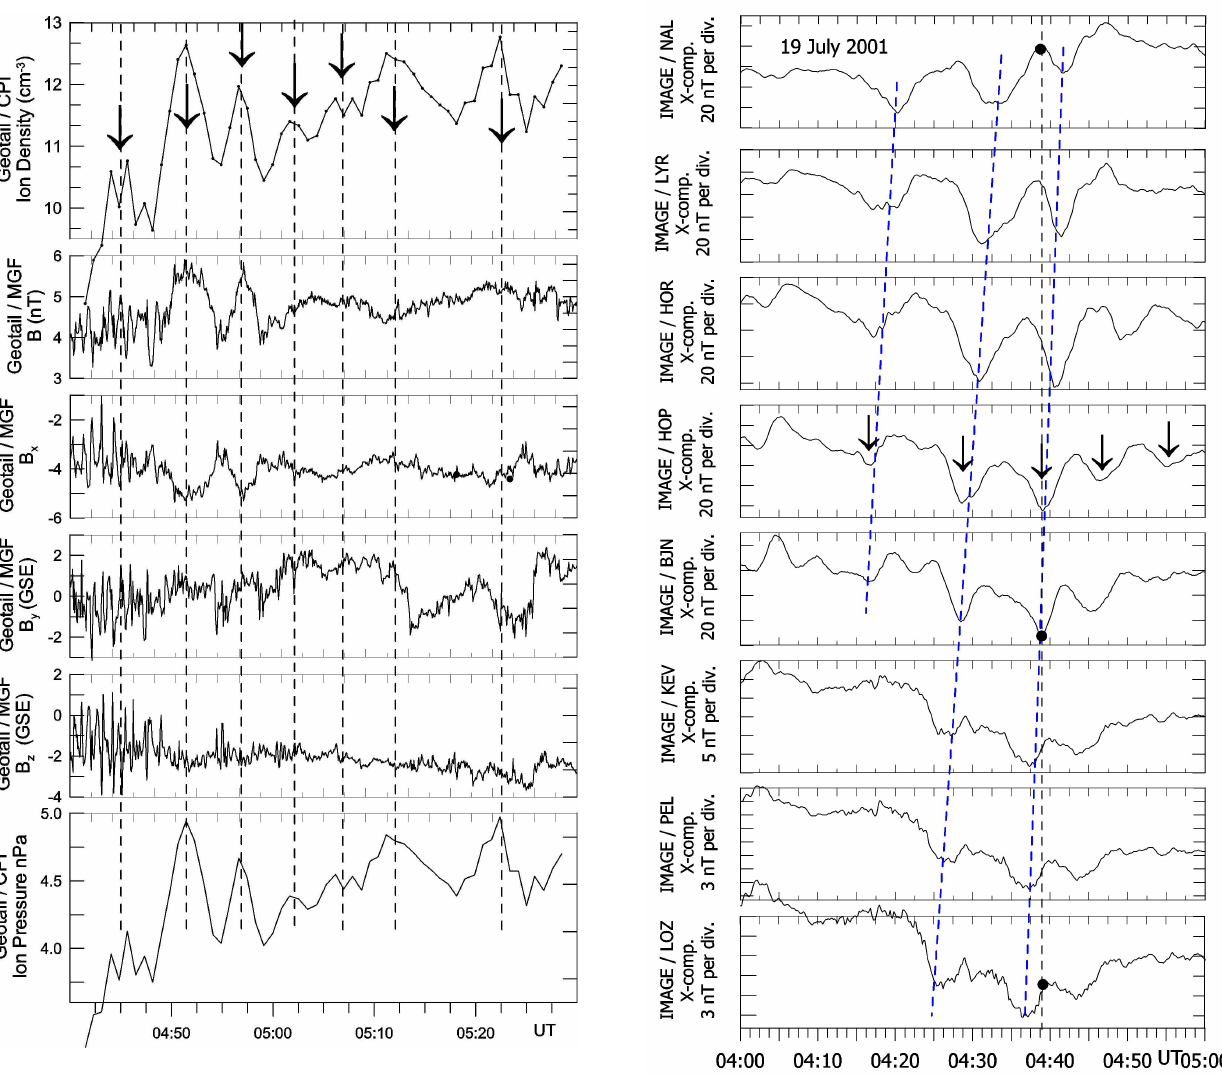
Fig. 12. Ion density, vector magnetic field data, and ion pressure measured by the Geotail satellite within the magnetosheath proper. These measurements correspond to the pulsation event presented in Fig. 11.